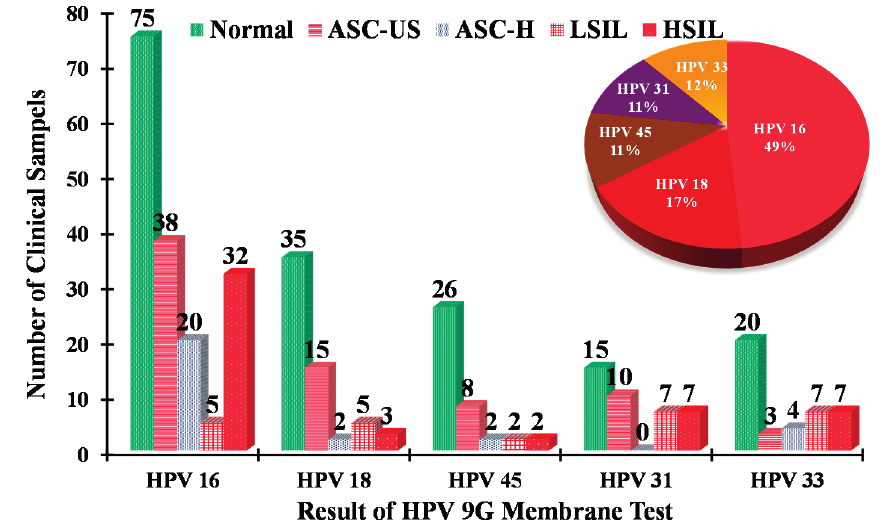
Figure 3. Distribution of HR-HPV genotypes in the samples categorized as normal, ASC-US, ASC-H, HSIL and LSIL by cervical cytology. The percentage distribution of five HR-HPV genotypes in the 350 clinical samples is depicted in the